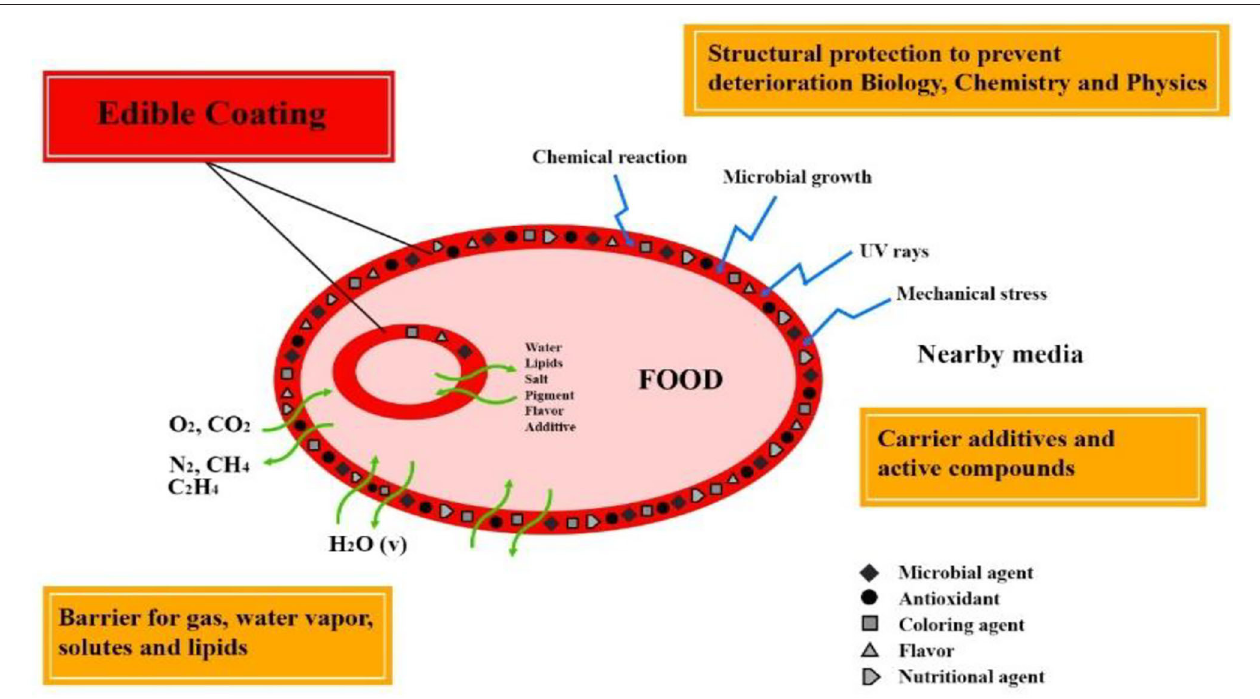
FIGURE 3 | Edible coating as protection, carrier additives, and barrier to